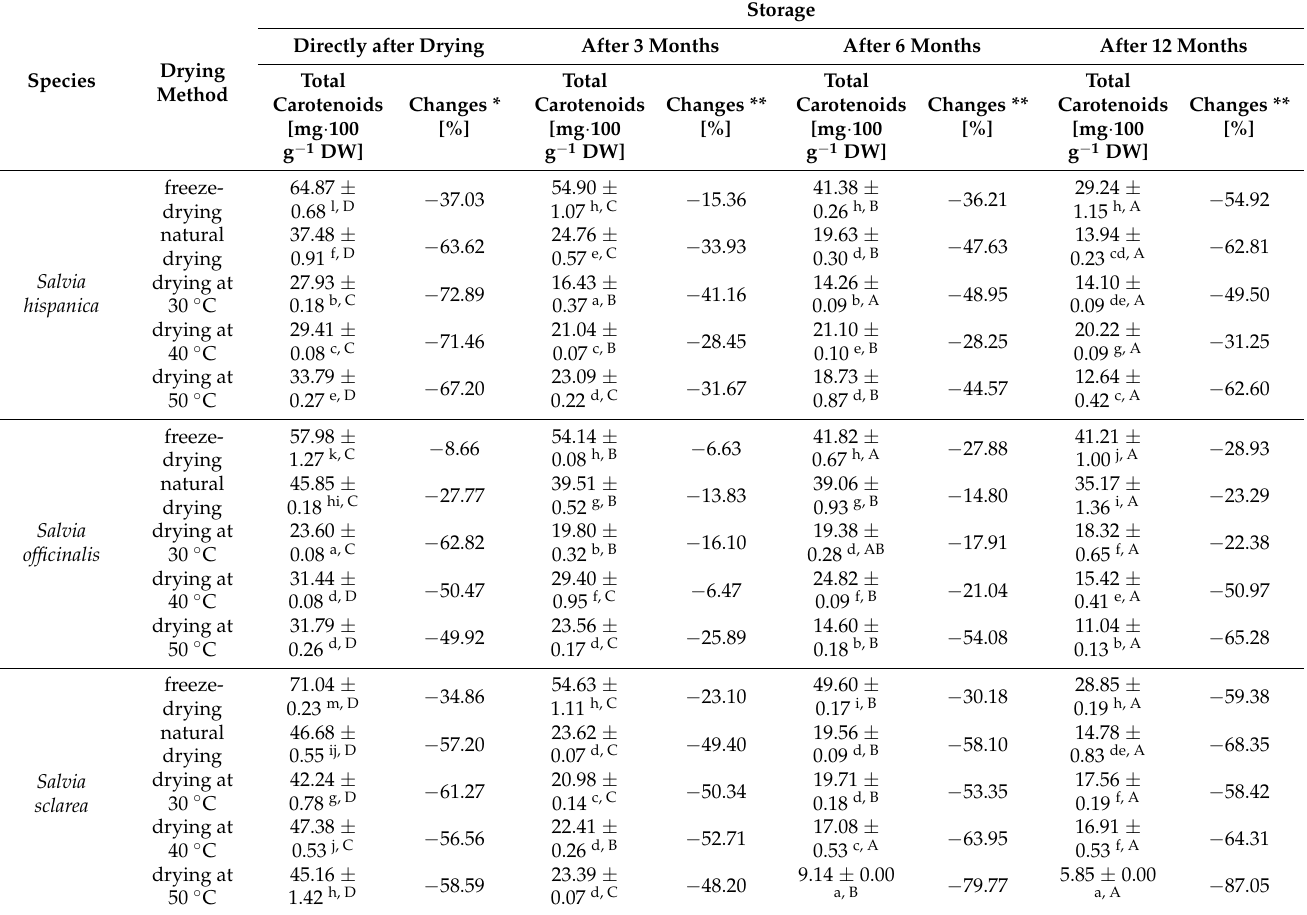
Table 3. The content of total carotenoids in dried and stored sage of individual